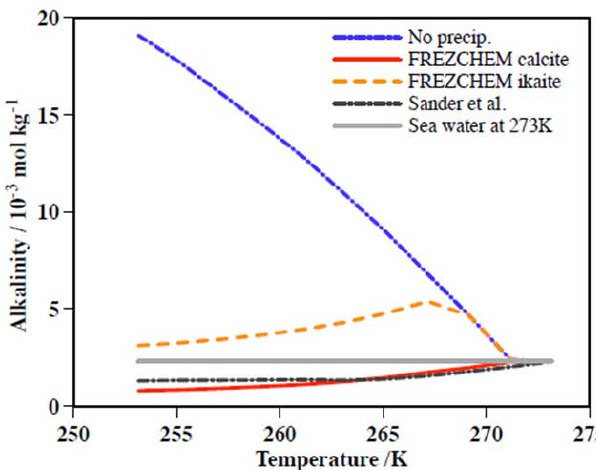
Fig. 4. Total alkalinity (AT) of the brine during the freezing of seawateras calculated by the FREZCHEM model with (a) carbon- ate precipitation artificially “switched off” (labeled “No precip”) (b) precipitation of calciteonly (“FREZCHEM calcite”) and (c) pre- cipitation of ikaite (“FREZCHEM ikaite”) only. Taken from Sander and Morin (2010) with permission of the authors.